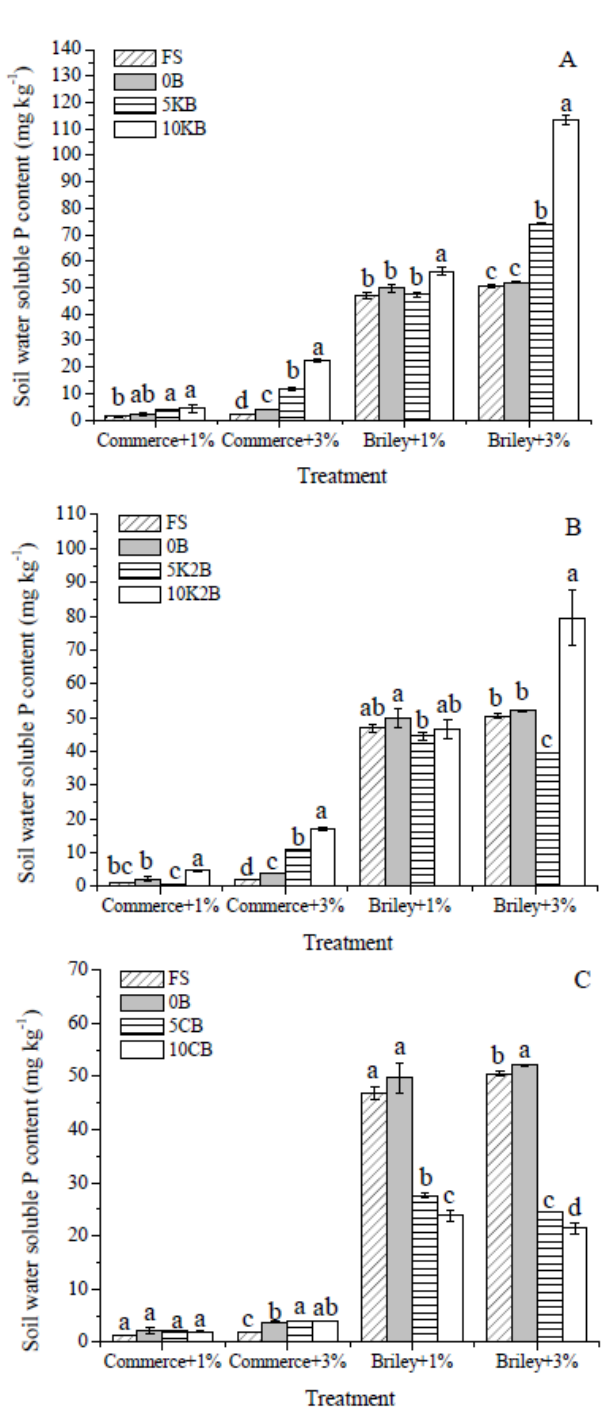
Figure 3. Water soluble P content of Si source amendments at applications of 1 and 3% in Commerce and Briley silt loam soil. Note: In the figure, subgraph ( A – C ) indicates KOH, K 2 CO 3 , and CaO of the alkali treatments, respectively. FS, rice straw feedstock; 0B, 5KB/K2B/CB, and 10KB/K2B/CB indicate the biochars prepared at the proportion of KOH/K 2 CO 3 /CaO to feedstock of 0:100, 5:100, and 10:100, respectively. Different letters indicate significant differences within treatment ( p < 0.05) based on Duncan’s multiple range test.